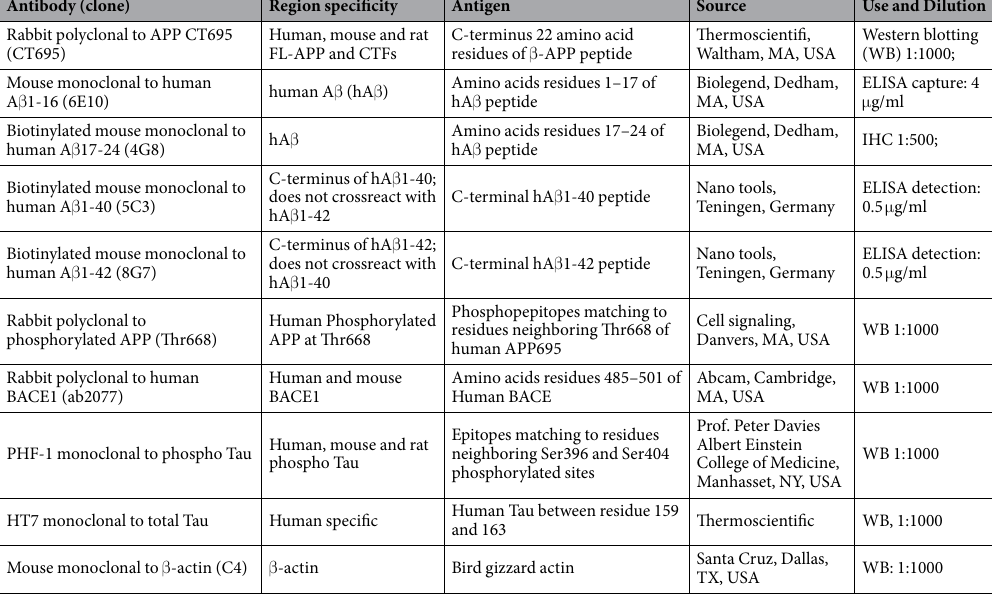
Table 1. Specifications of antibodies used in this